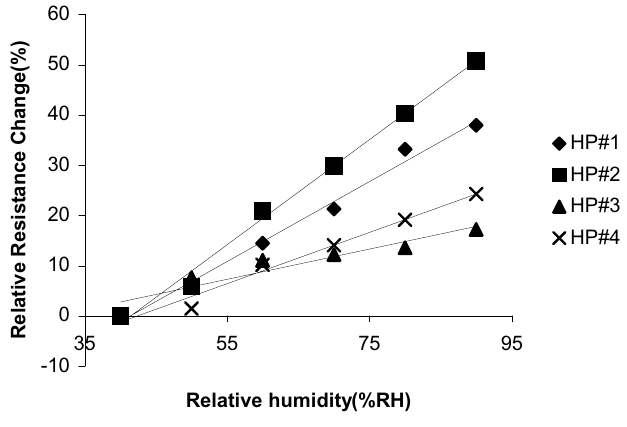
O /SiO, produced at high vacuum pressure, at 2 3